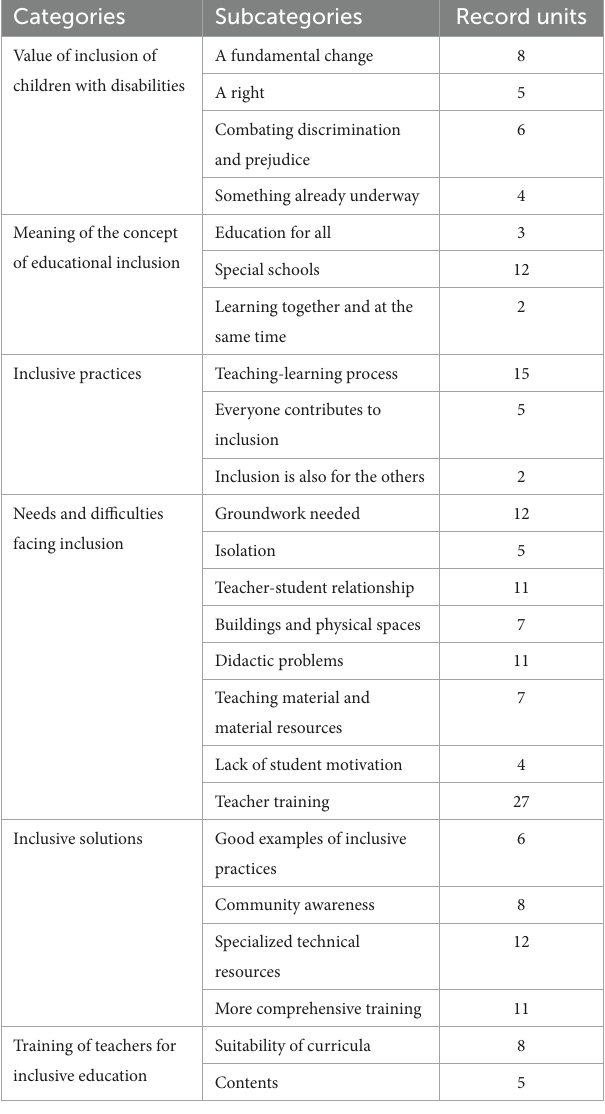
TABLE 2 Classification of categories and